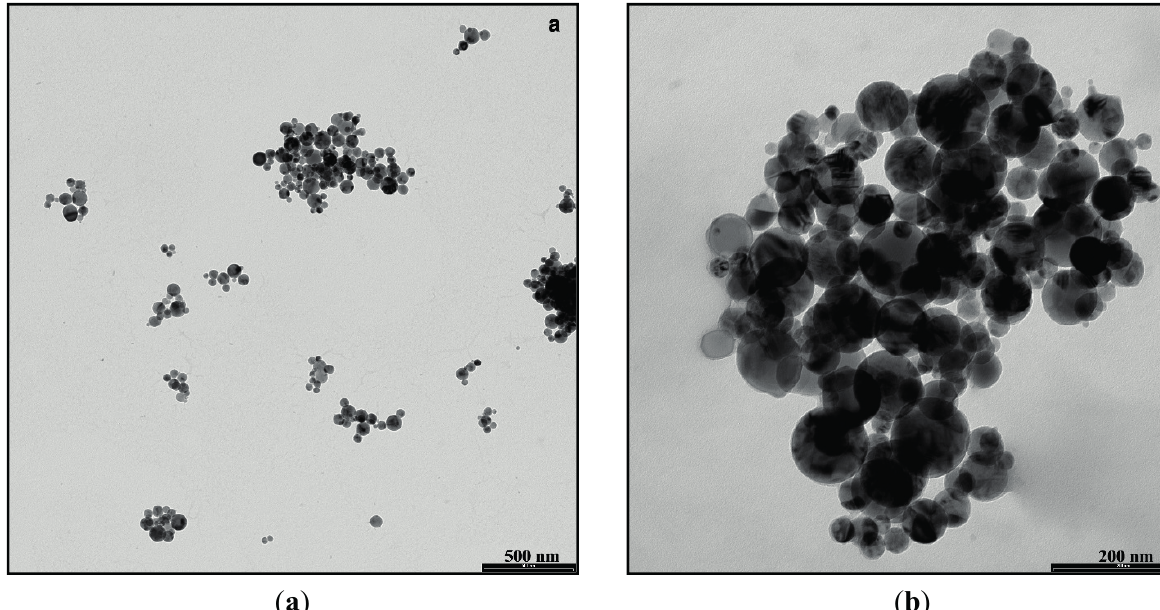
Figure 1. Representative Transmission Electron Microscopy images of agglomerated TiO 2 NPs dispersed in synthetic sweat at the beginning of the experiments (Bar: ( a ) = 500 nm, ( b ) = 200